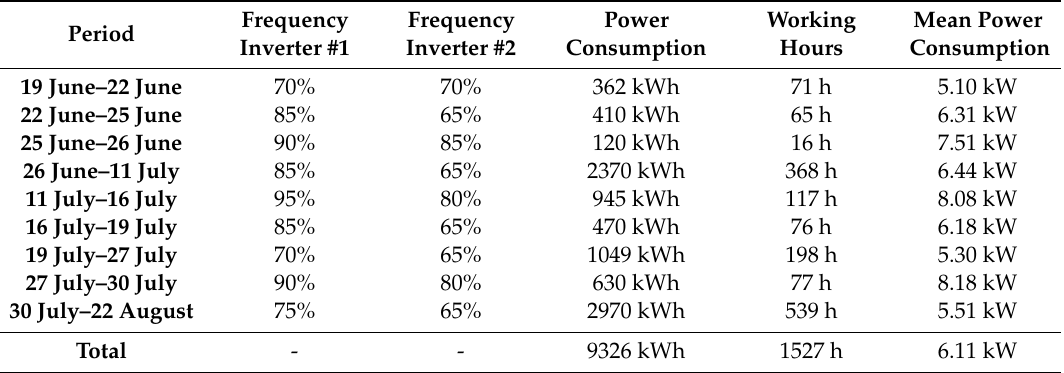
Table 5. Operating modes tested in the third period (19 June 2019 to 22 August 2019) of experimental tests. The frequency of each inverter is expressed as a percentage in the range 12.5–50 Hz, being 0% corresponding to 12.5